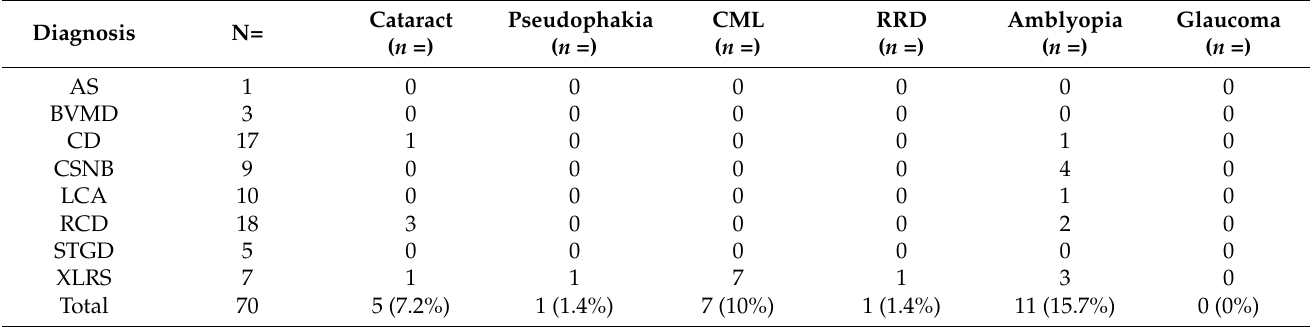
Table 4. Other ocular co-morbidities by clinical diagnosis (in alphabetical order).